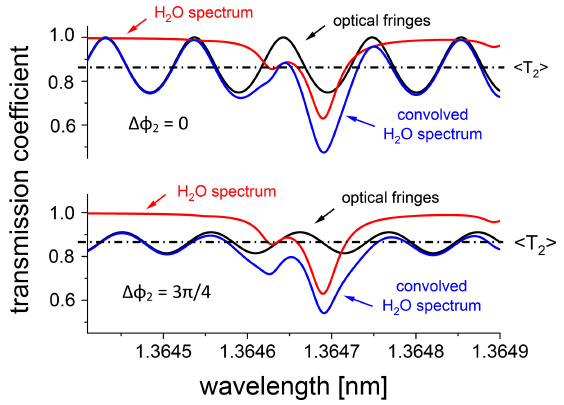
Figure 5. Examples of the optical interference in the glass windows of LACIS-T ( d = 8mm) for n = 10 17 cm − 3 and two different val- ues of (cid:49)ϕ 2 .